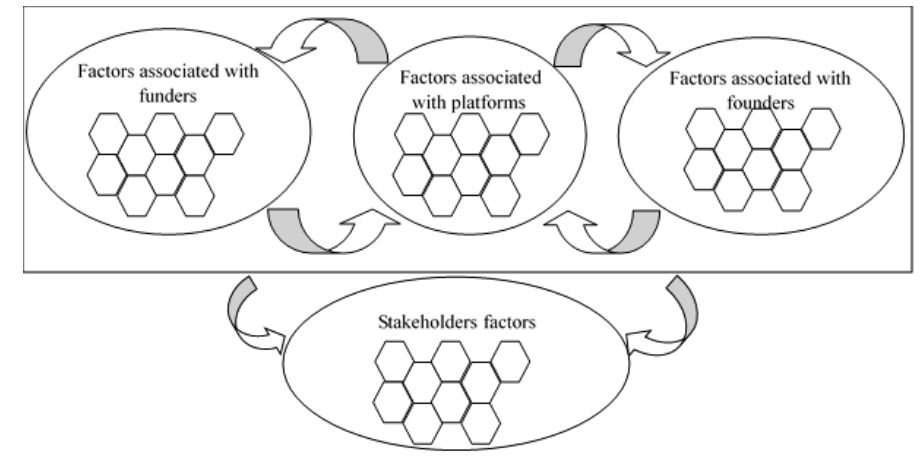
Figure 9. Clustering hexagons based on the stakeholder